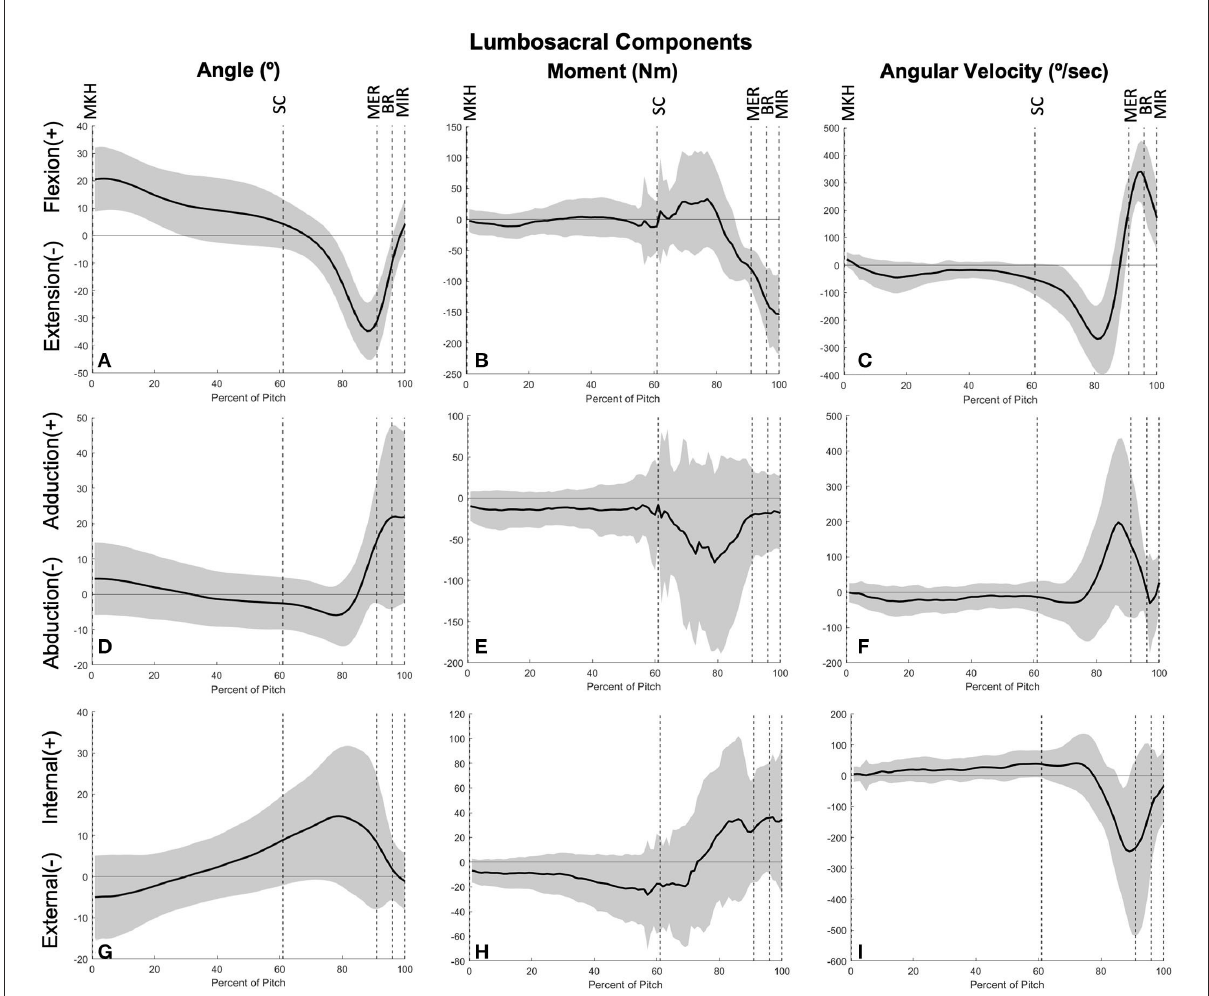
FIGURE11 Mean ± SD joint angle, joint moment, and joint angular velocity for the lumbosacral joint in extension/flexion (A–C), ab/adduction (D–F) , and internal/external rotation (G–I) for the duration of the pitch from maximum knee height (MKH) to maximum internal rotation (MIR).